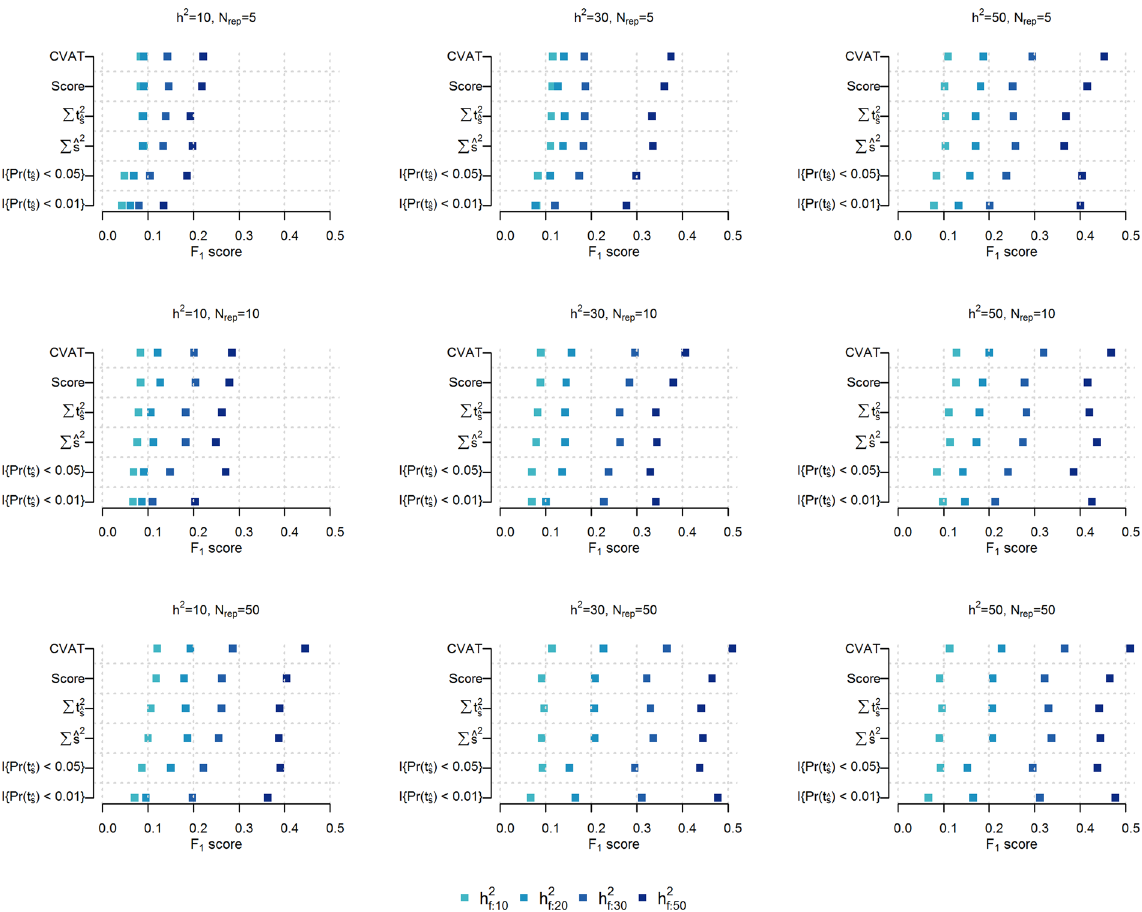
Figure 1. Comparison of detection power between set test statistics. The F 1 score (x-axis) was used to measure the performance of the GBLUP derived set test statistics (y-axis), i.e. T CVAT (CVAT), T Score (Score), T Sum using single marker effects ∑ ^ ( s ) 2 or using single marker t-statistics ∑ ^ ( t ) s2 , and T Count with a threshold of p-value < 0.05 < . and p-value < 0.01 < . . The F 1 score was calculated using the average set test ˆ (I{Pr(t ) 0 05}) s ˆ (I{Pr(t ) 0 01}) s statistic results over a dilution range of adding 0 to 2000 non-causal SNPs to the C 1 causal set. P-value cut-off for the set test statistic was 0.05. Each panel represent a different combination of genomic heritability (h 2 ) and number of replicates within lines (N rep ), whereas h f2 is visualized by the colour gradient. Results are for the scenarios with three different levels of genomic heritability (h 2 = 0.1, 0.3 or 0.5, columns left to right), four different levels of proportion of genomic variance explained by the causal markers in the genomic feature ( h f2 = 0.1, 0.2, 0.3 or 0.5, light to dark colour), and three different levels of number of replicates within lines (N rep = 5, 10, or 50, rows top to bottom). Causal sets, including SNPs in feature ( C 1 ) and not in feature ( C 2 ), consisted of SNPs randomly selected from the complete SNP set (random causal